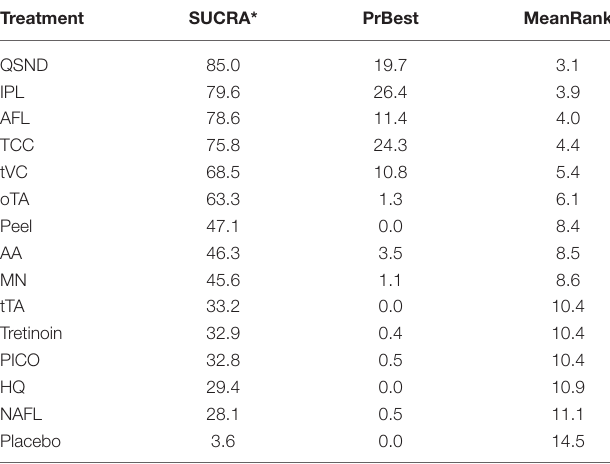
TABLE 2 | Summary of side effects.